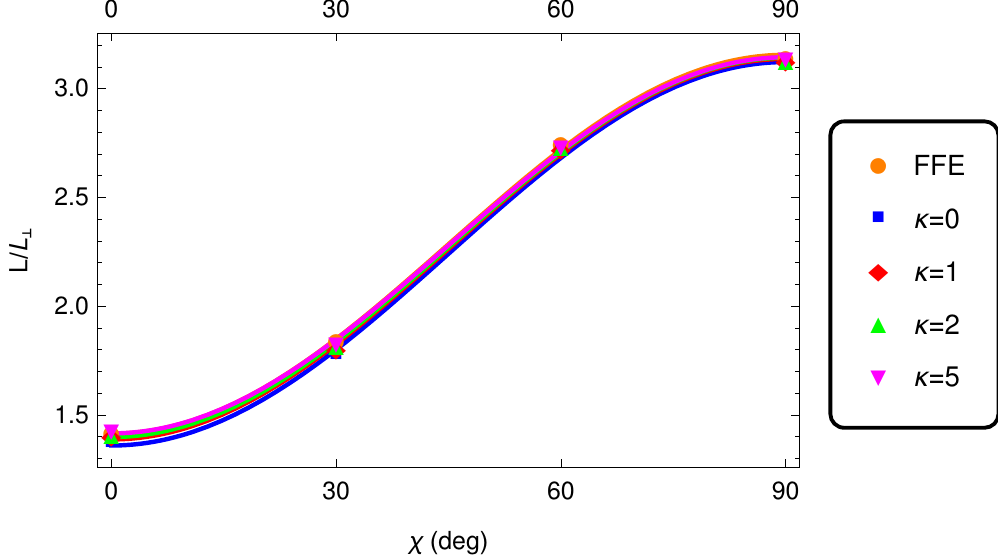
Figure 3. The Poynting flux crossing the light cylinder for oblique rotators in force-free and radiative regimes corresponding to Figure 2. Table 1. Fitting coefficients a and b for the spindown luminosity as fitted in Equation